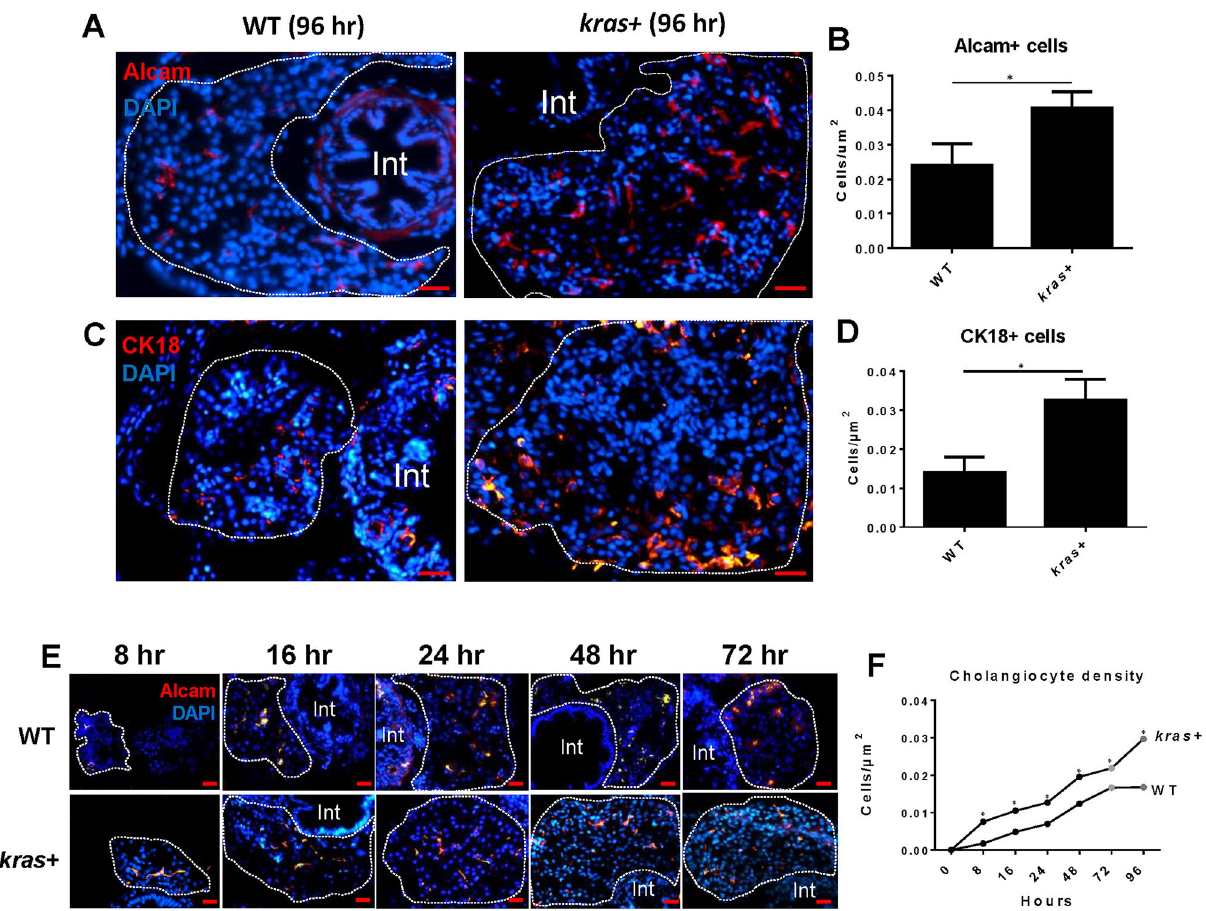
Figure 1. Increase of cholangiocytes upon induction of oncogenic kras V12 expression in hepatocytes of kras + transgenic zebrafish larvae. Cholangiocytes were determined by using two different molecular markers: Alcam and Cytokeratin 18 (CK18). 3-dpf kras + and WT zebrafish larvae were treated with 20 µg/ml Dox till 7 dpf. Samples were collected at different time points after Dox induction for immunohistochemistry. All liver sections were counter stained with DAPI. ( A – D ) Representative images of Alcam antibody ( A ) and Cytokeratin 18 (Ck18) ( C ) and quantification of cholangiocyte density ( B , D ) in kras + and WT larvae at 96 h following Dox induction. ( E , F ) Time course of increase of cholangiocytes from 8 to 96 h following Dox induction. Representative images of Alcam staining of kras + and WT larvae from 8 to 72 h are shown in ( E ) and 96 h in ( A ). Quantification of cholangiocyte density in kras + and WT larvae is shown in ( F ). N = 10 at each time point. Scale bar: 20 μm. Statistical significance: *P ˂